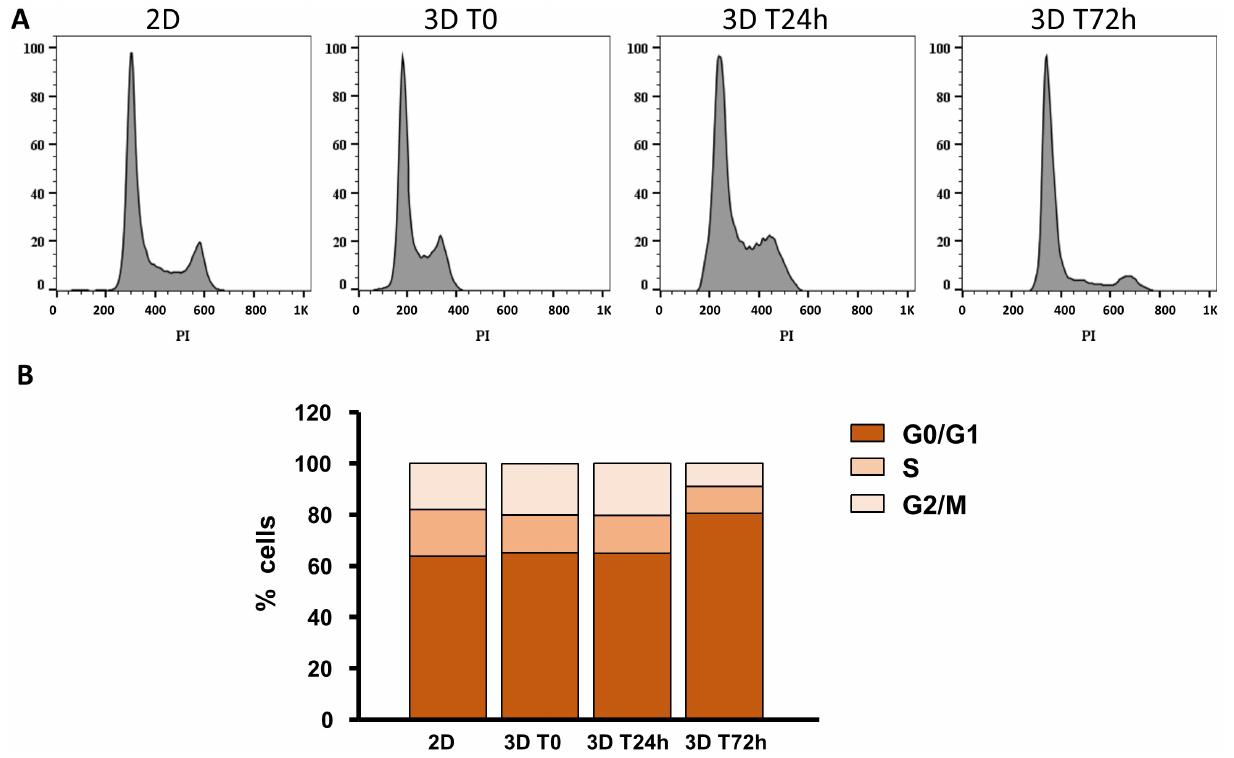
Figure 5. Cell cycle in unprinted and printed cells. ( A ) Representative cell cycle obtained by FACS for Calu-3 cells in 2D culture and 3D-printed at Time 0, after 24 and 72 h in culture, respectively. ( B ) Cell cycle for the culture obtained in ( A ) phases: G0/G1, S, G2/M. PI: propidium iodide (n =